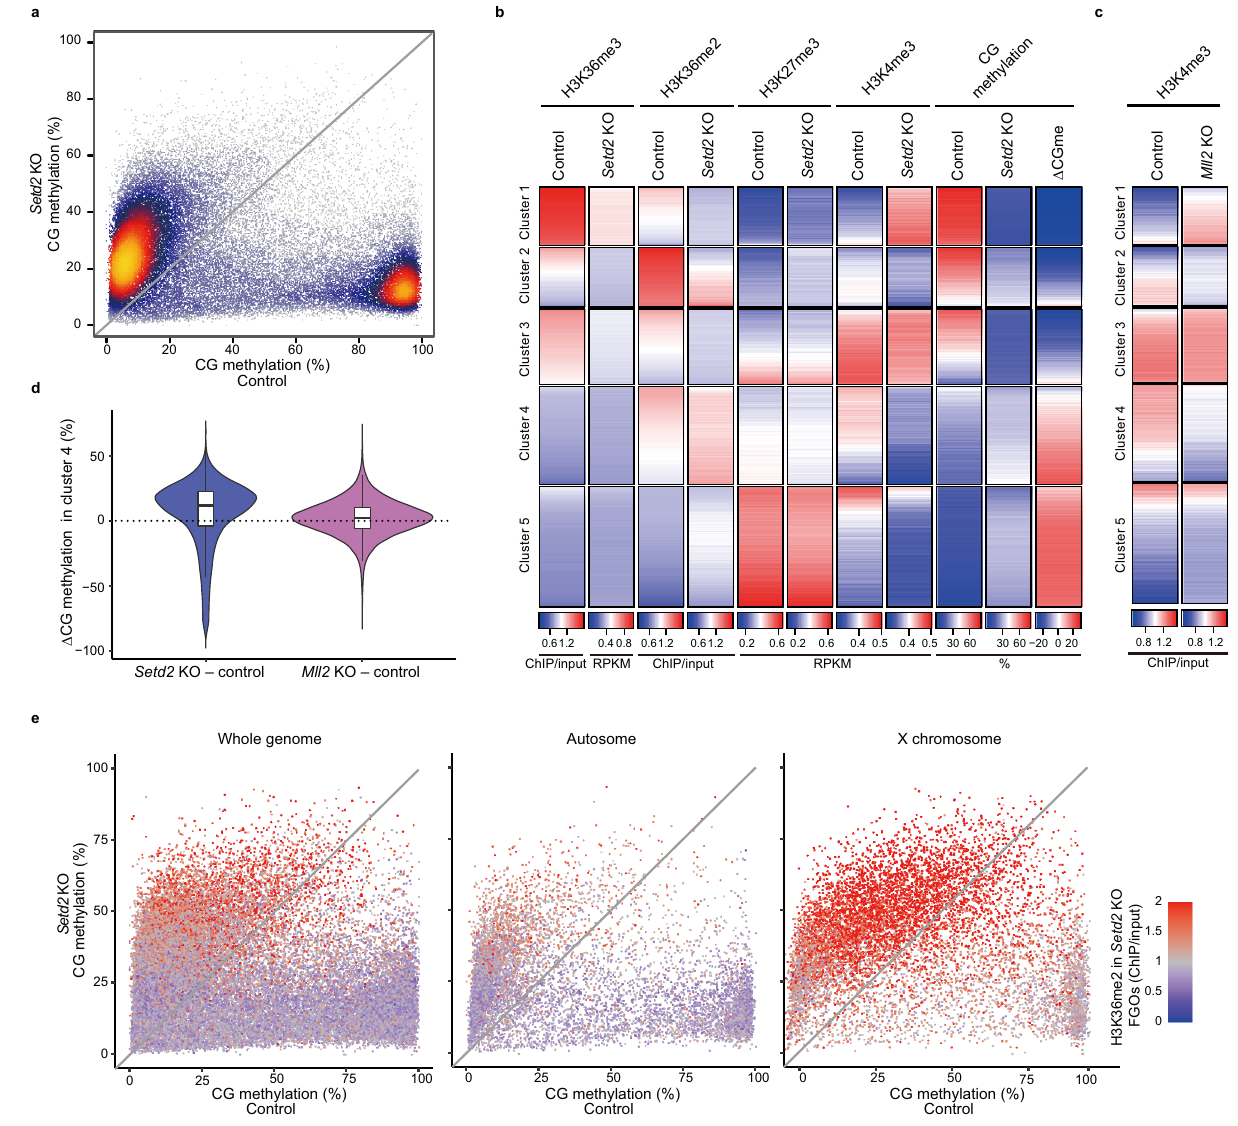
Fig. 4 | Loss of H3K36me3 results in an excessive gain of CG methylation in genomic regions with speci fi c histone marks. a Scatter plots showing CG methylationlevelsincontroland Setd2 KOFGOs.Fiftythousandrandomlyselected 10kb bins were plotted. b Heatmaps showing H3K36me3, H3K36me2, H3K27me3, and H3K4me3 enrichment and CG methylation levels in 10kb bins in control and Setd2 KOFGOs 11,14 .CGmethylationdifferencesbetween Setd2 KOandcontrolFGOs ( Δ CGme).ThedataweresortedinthesameorderasinFig.3a. c Heatmapsshowing H3K4me3 enrichment in 10kb bins in control and Mll2 KO FGOs 12 . d Violin plots